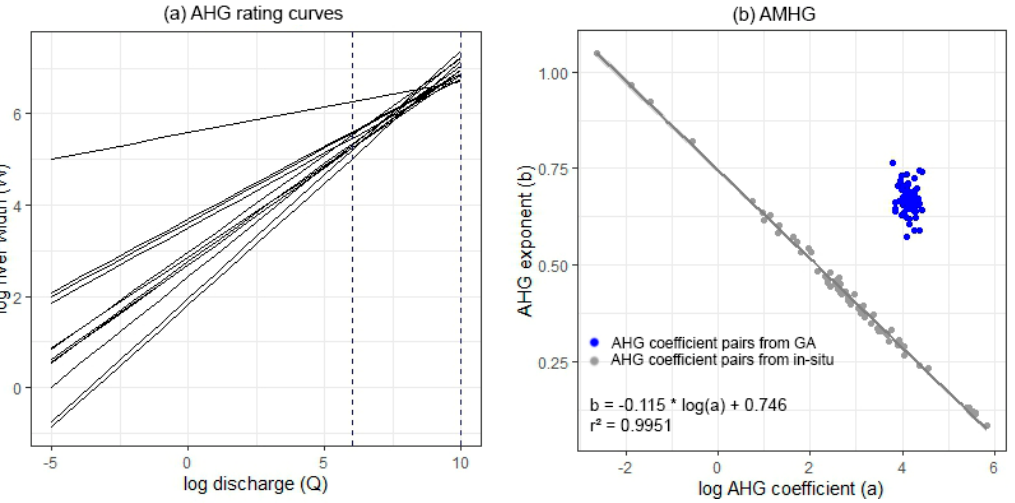
Figure 13. ( a ) Individual AHG rating curves (black lines) derived from cross sectional width measurements of the study region intersect around the same log(Q) – log(W) values within the observed discharge range (dashed line). ( b ) This behavior leads to the mathematical rise of AMHG, where AHG coefficient pairs (gray points) can be described by a log-linear function (gray line). AHG coefficient pairs derived from the genetic algorithm are colored in blue.